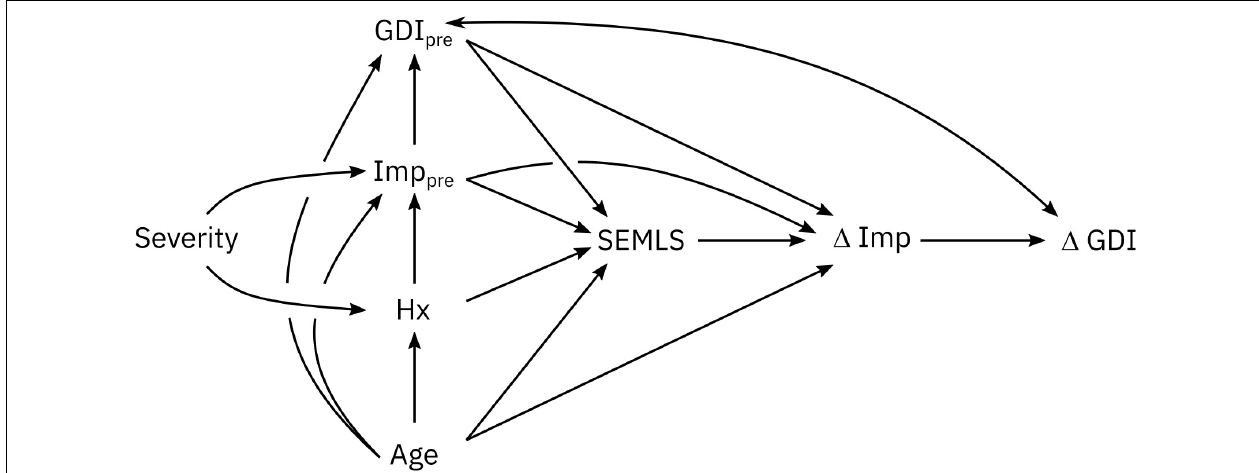
FIGURE 1 | DAG describing the assumed causal relationships between SEMLS (exposure) and (cid:49) GDI (outcome). The causal relationship between SEMLS and (cid:49) GDI is mediated by changes in impairments ( (cid:49) Imp). Baseline GDI (GDI pre ) and (cid:49) GDI are related by measurement methods and other, unmeasured factors. Baseline impairment (Imp pre ), surgical history (Hx), and Age are also included as causal factors. The DAG also includes unmeasured factors related to general CP severity, which impact baseline impairment and surgical history. The step-by-step process and rationale for this DAG are available in the Supplementary Material and an interactive version is available on dagitty (http://dagitty.net/mUCSPWo).